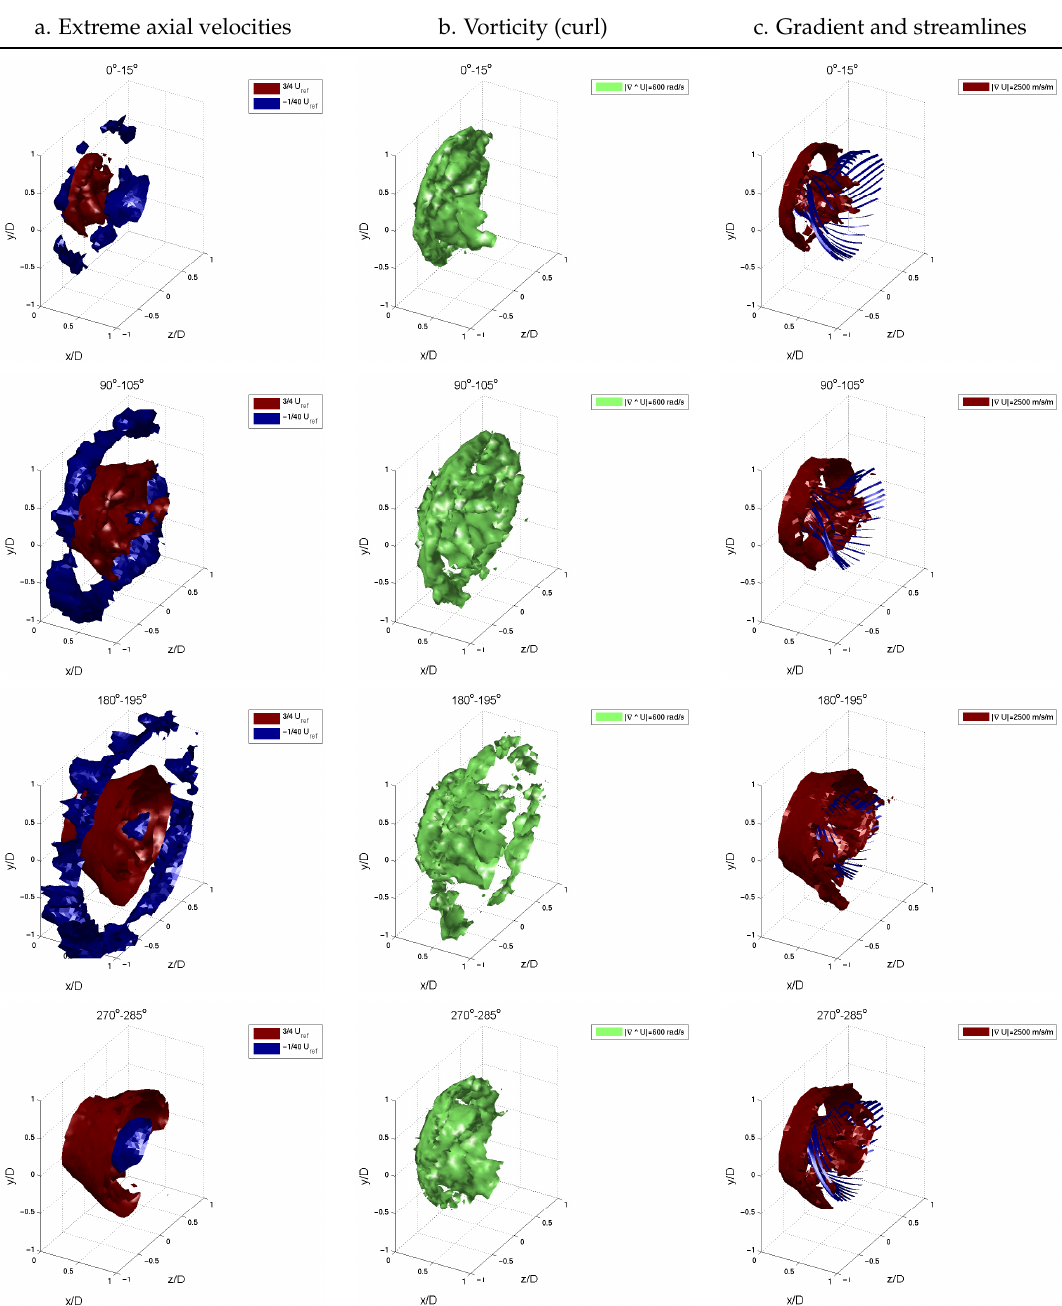
Figure 24. 3D analysis of the airblast aerodynamics, measured with conditioned Laser Doppler Anemometer (LDA) and phase-averaged [19,27]. ( a ) Extreme axial velocities u to sort out the air jet shape and the recirculating zones. ( b ) Analysis of the field vorticity, applying the curl operator ∇ ∧ U(u,v,w) . ( c ) Analysis of the mixing layer positions (gradient operator and normalisation: |∇ U(u,v,w) | ) comparison with the 3D streamlines emitted from the liquid